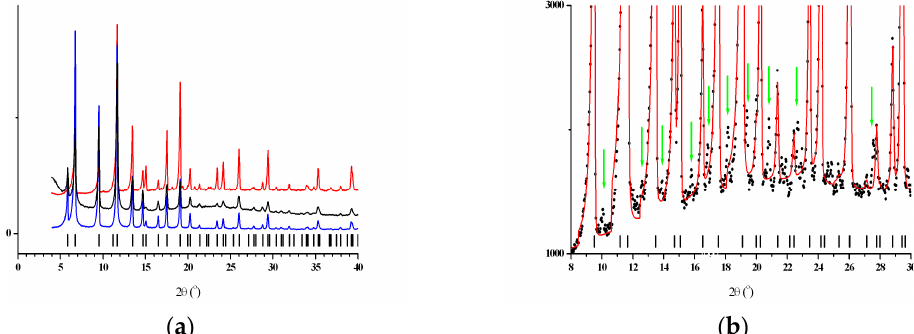
Figure 2. ( a ) The combined presentation of the XRD patterns of the HKUST-1 mw (red), HKUST-1 solv.1 (blue), and HKUST-1 solv.2 (black) samples. The vertical black bars denote the positions of the peaks calculated for the cubic unit cell in the space group Fm-3m. ( b ) The experimental (black dots) and calculated (red line) powder XRD patterns of the HKUST-1 mw sample. The vertical black bars denote the positions of the peaks calculated for the cubic unit cell in the space group Fm-3m. The vertical green arrows show the positions of some additional weak peaks.